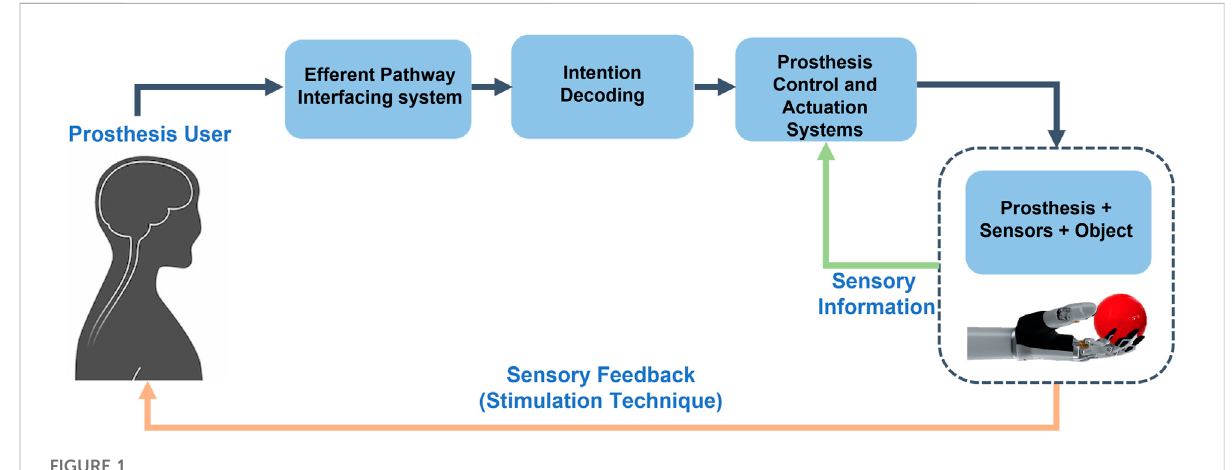
FIGURE 1 Block scheme of the control loop of a prosthetic